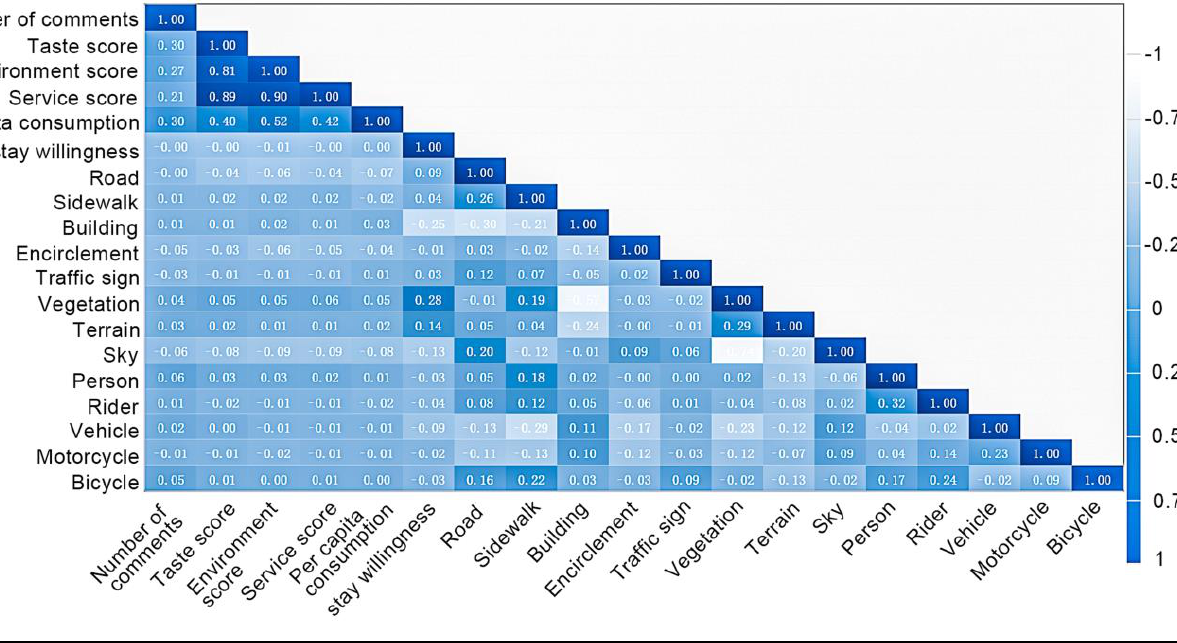
Figure 8. Results of the Pearson’s correlation.